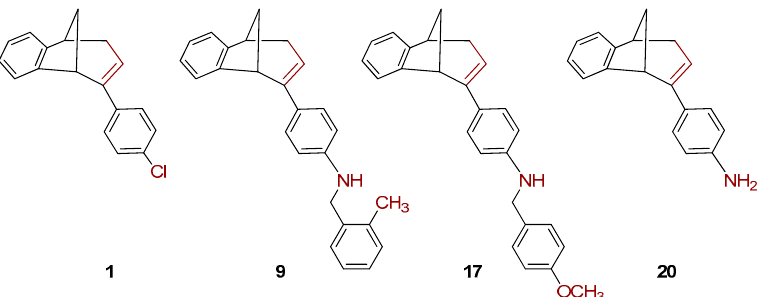
Figure 3. The rearranged products 1 , 9 , 17 and 20 obtained during amination of endo - 1 .